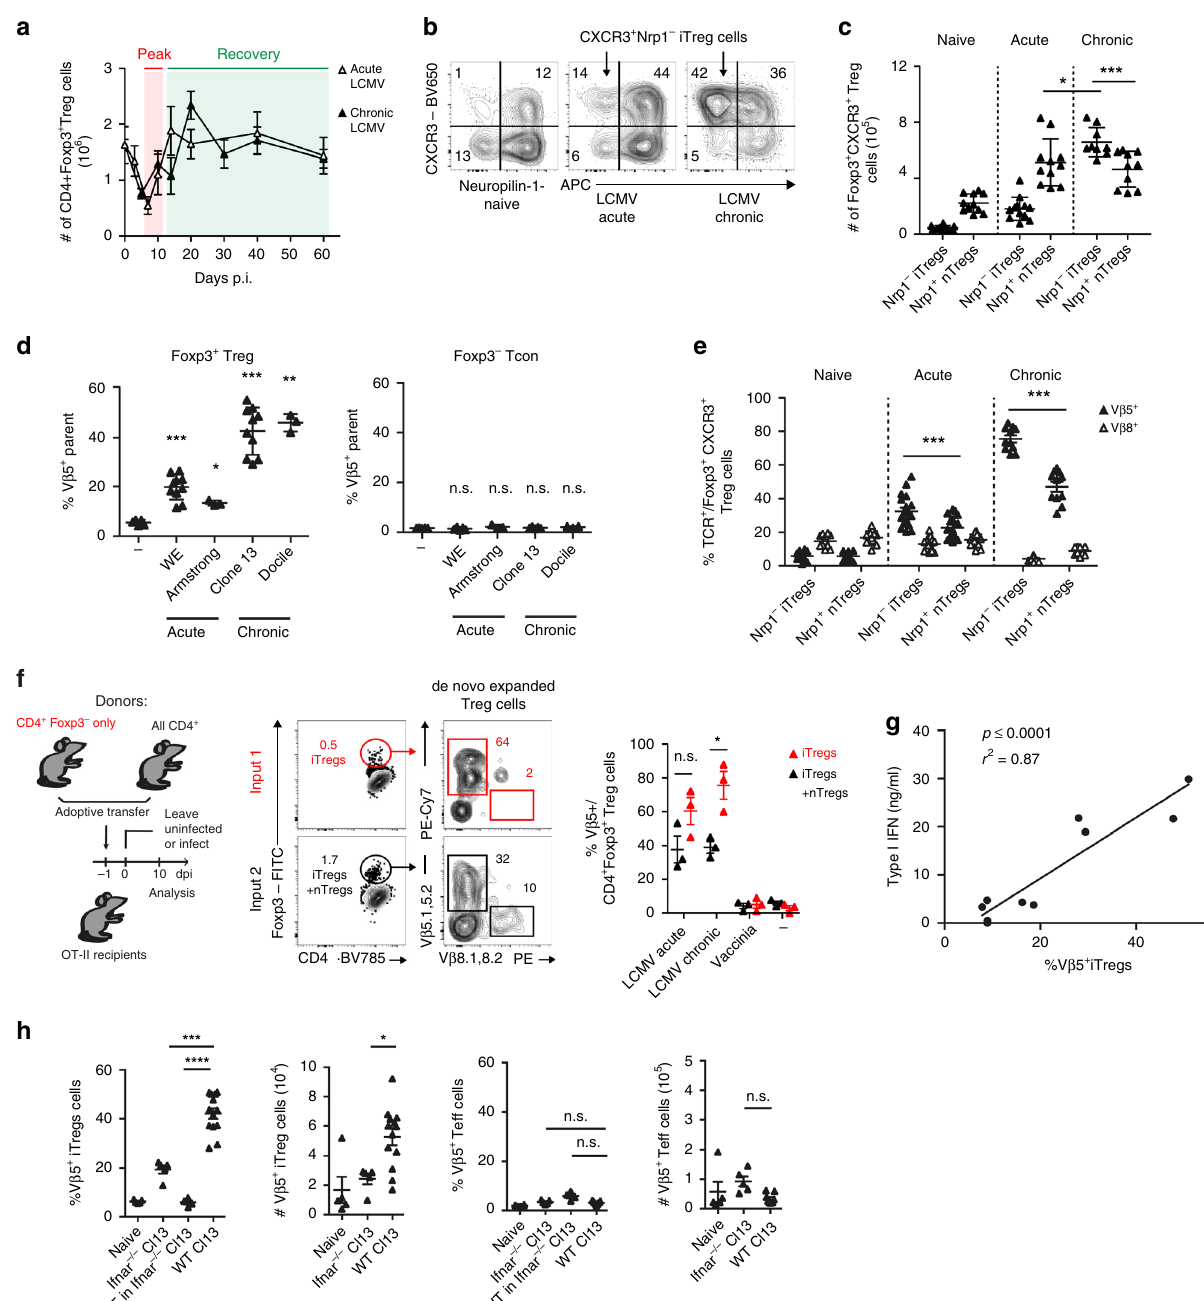
Fig. 1 Induced Treg cells compensate for Treg cell loss caused by type I interferons. a – c WT mice were infected with 200f.f.u. LCMV WE (acute), 10 6 f.f.u. LCMV clone 13 (chronic), or were left naive. a Total numbers of CD4 + Foxp3 + splenic Treg cells were determined by fl ow cytometry throughout the course of infection ( n = 3 – 11). Frequencies ( b ) and total numbers ( c ) of CD4 + Foxp3 + CXCR3 + Nrp1 − iTreg and CD4 + Foxp3 + CXCR3 + Nrp1 + nTreg cells were